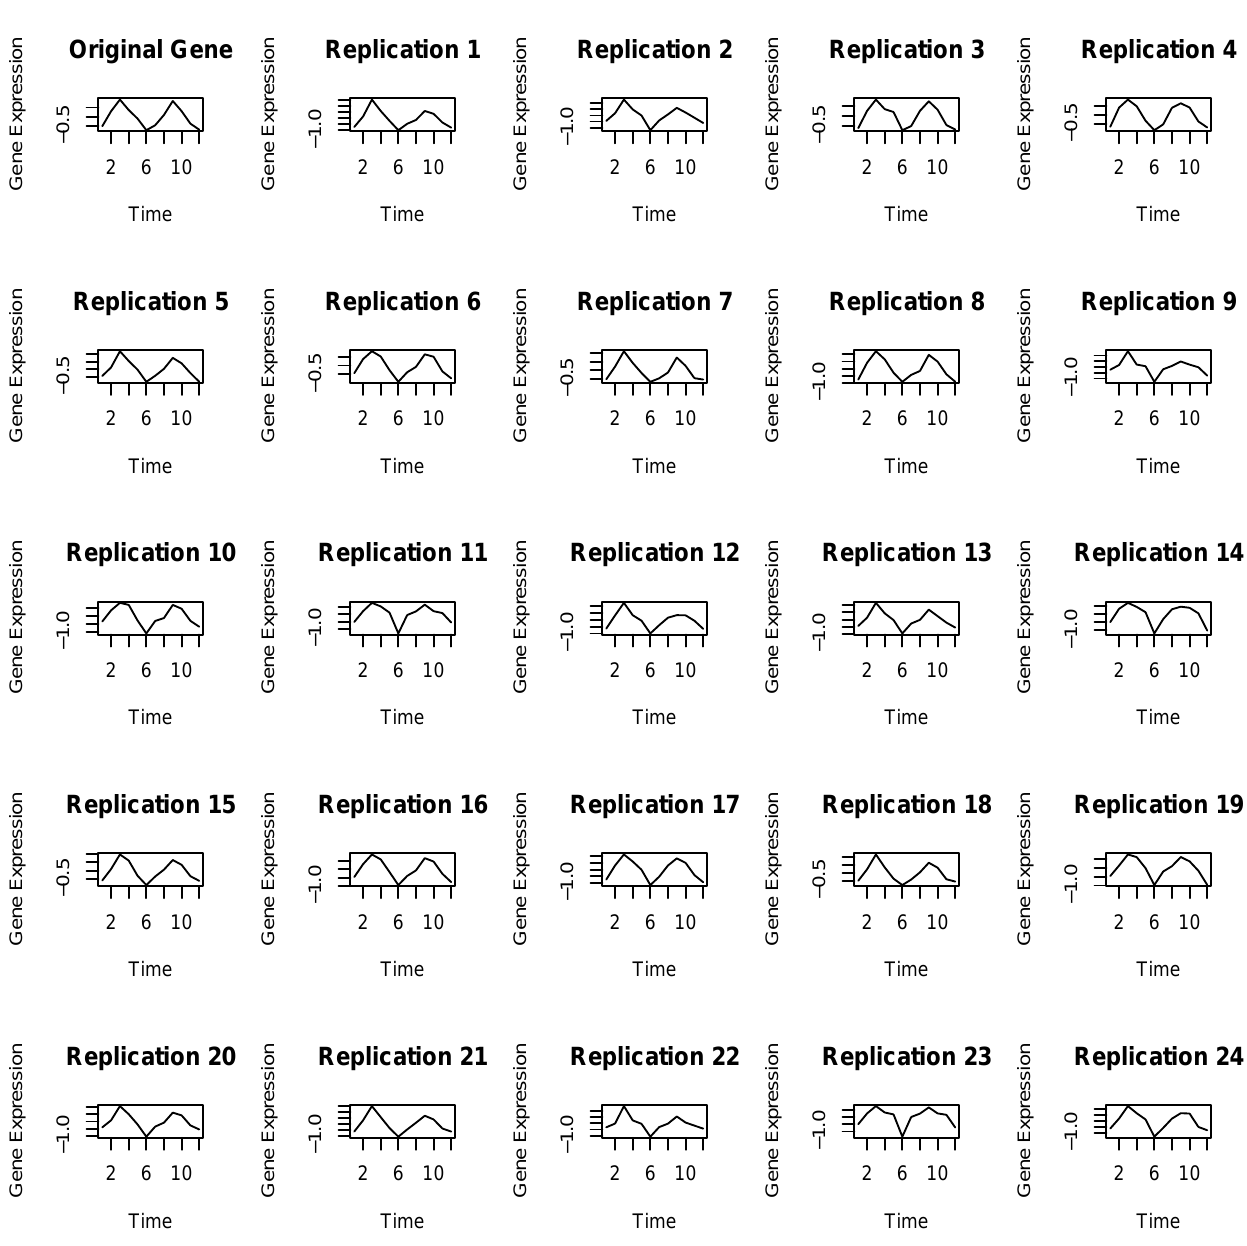
Fig 3. An Example of data resampling using the Maximum Entropy Bootstrap Algorithm. (Top left panel): A gene expression time series from the IWAT data. (Remaining:) Set of 24 replications randomly chosen from 999 maximum entropy bootstrap samples used in the analysis.